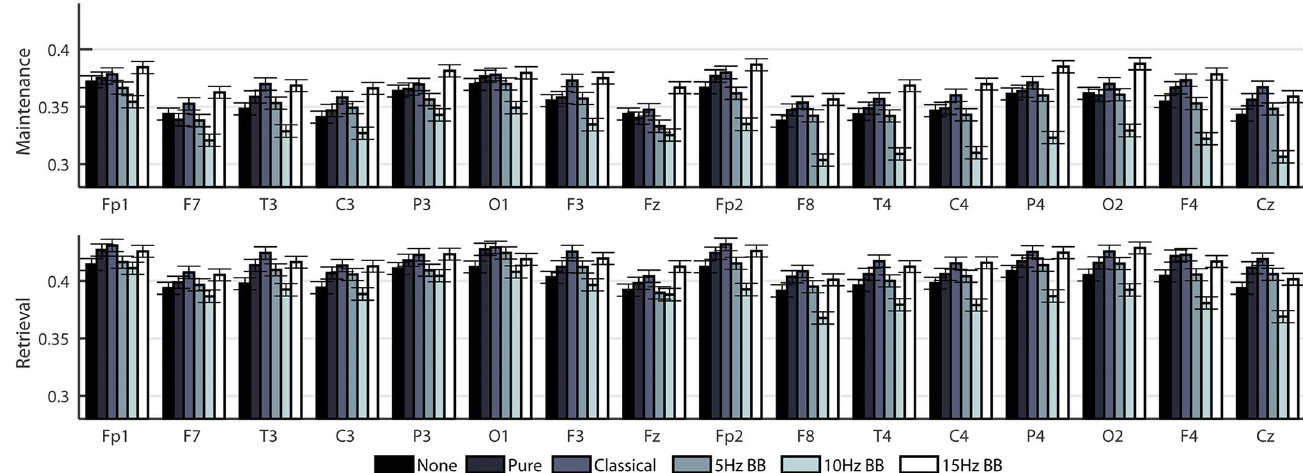
Fig 7. Mean clustering coefficient of EEG nodes in cortical networks for all six acoustic stimulation conditions. Bars indicate standarderror.